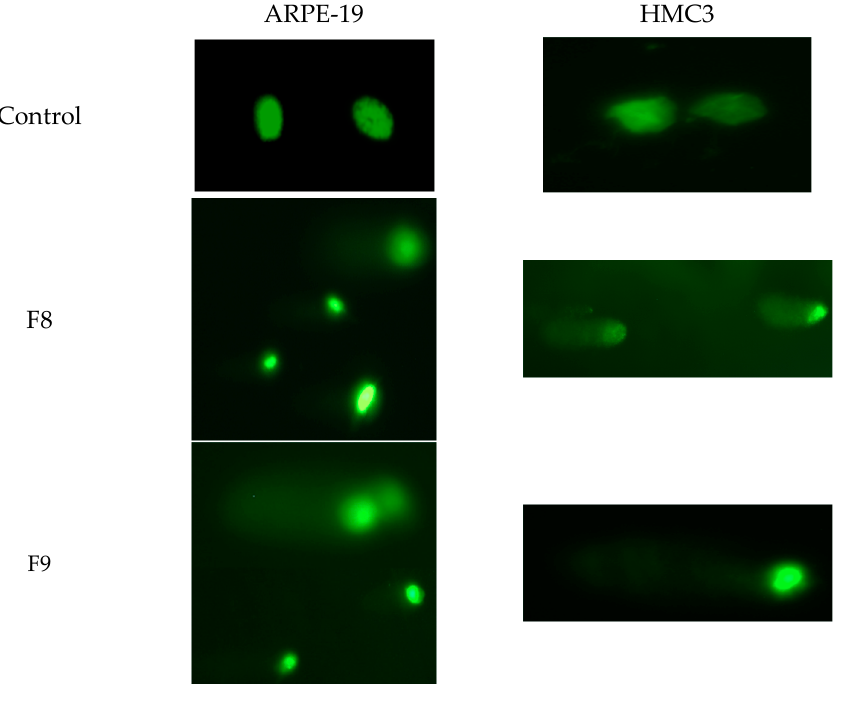
Figure 4. Genotoxic effects induced by nanoemulsions with TA in ARPE-19 and HMC3 cell lines. Images obtained with 20× objective.